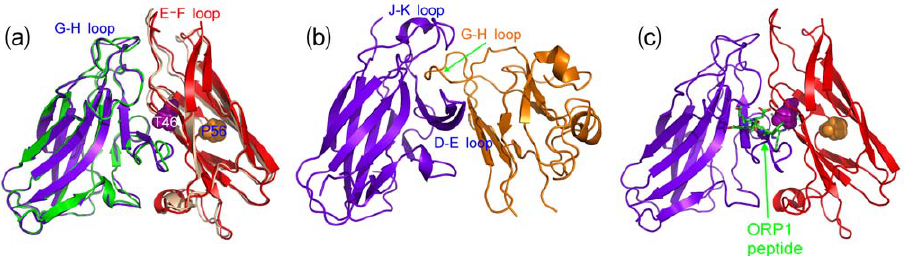
Figure 6. Docking model for the EphA4-MSP complex. (a). Superimposition of two lowest energy docking model of the EphA4-MSP complex. (b). The crystal structure we previously determined for the EphA4-ephrinB2 complex [40]. (c). The docking model of the EphA4-MSP complex with the FFAT-containing ORP1 peptide displayed according to the VAPA MSP-ORP1 structure [12].